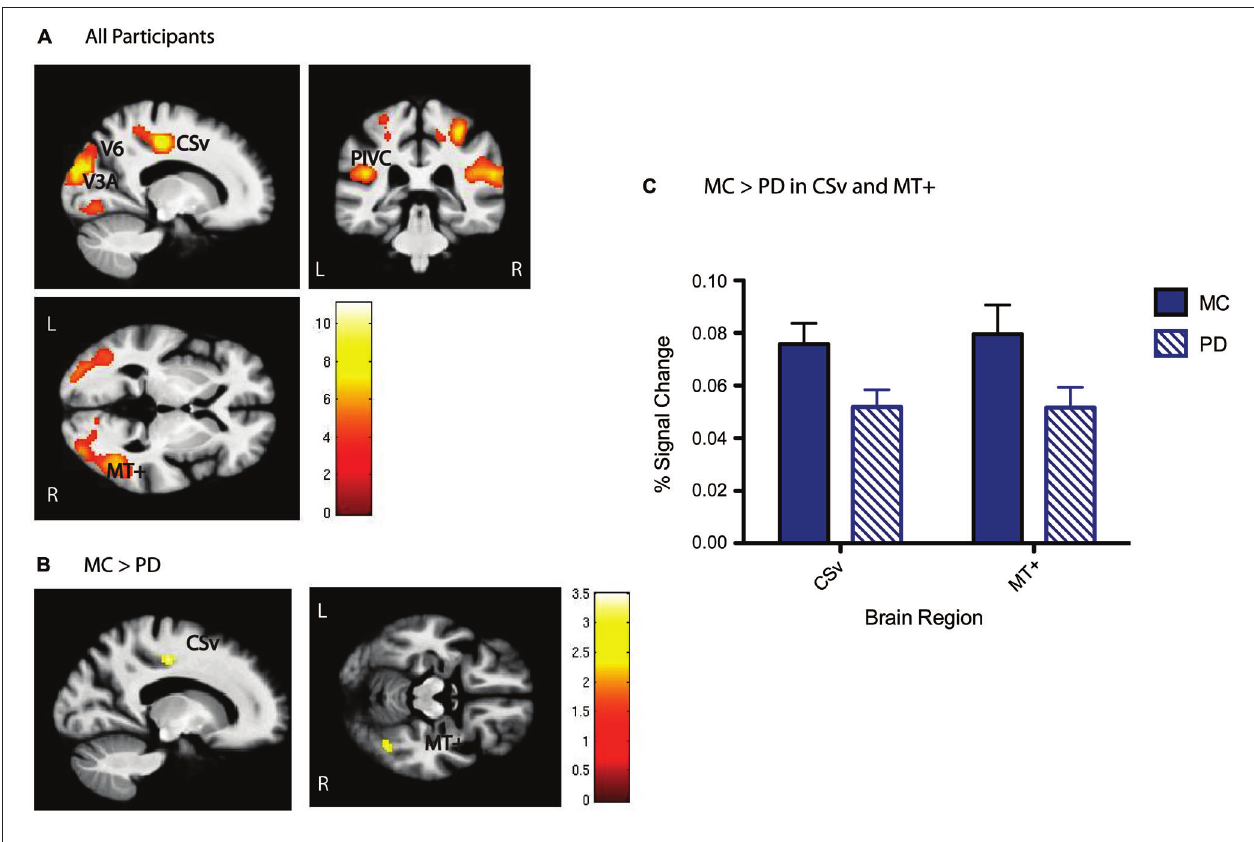
that CSv and MT+ are significantly more activated in MC than PD, p < 0.01 cluster corrected with a 40 voxel extent threshold. Scale bars represent the t -statistic. (C) Results presented here are another visualization of magnitude of activation presented in (B) , depicting higher activation in CSv and MT+ for MC than